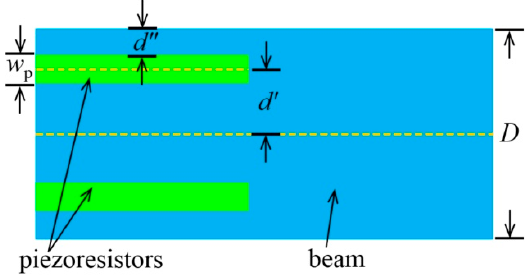
Figure 3. Schematic of the piezoresistor beam positions and the parameters used in Equations (4) and (5).